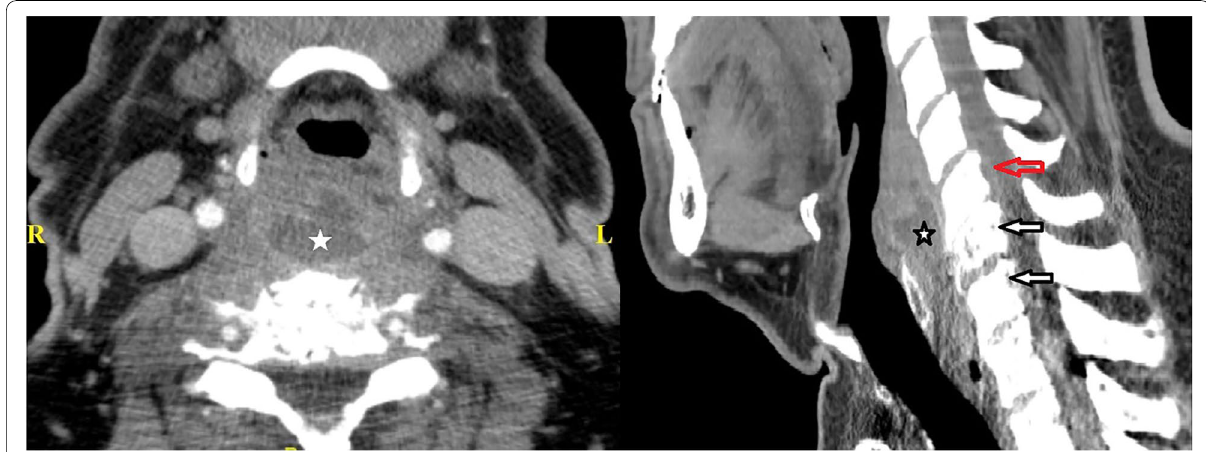
Fig. 1 Axial and sagittal sections of CT: the stars show the retropharyngeal abscess, and the arrows show the degeneration of C5–6 vertebrae